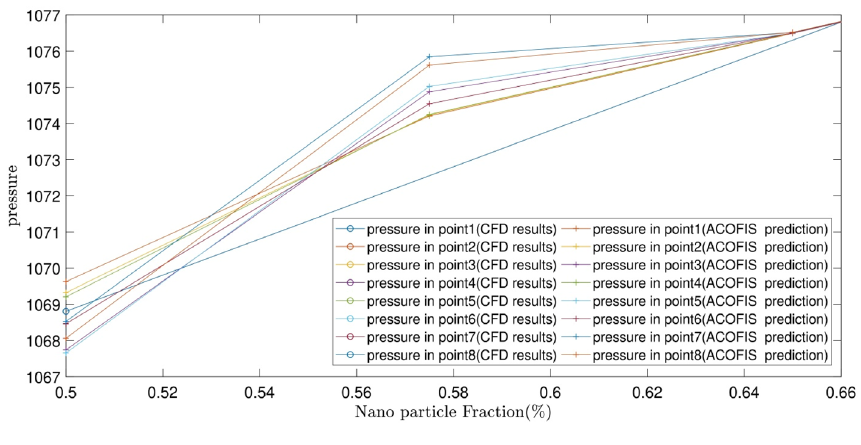
Figure 10. Selected area in Fig.